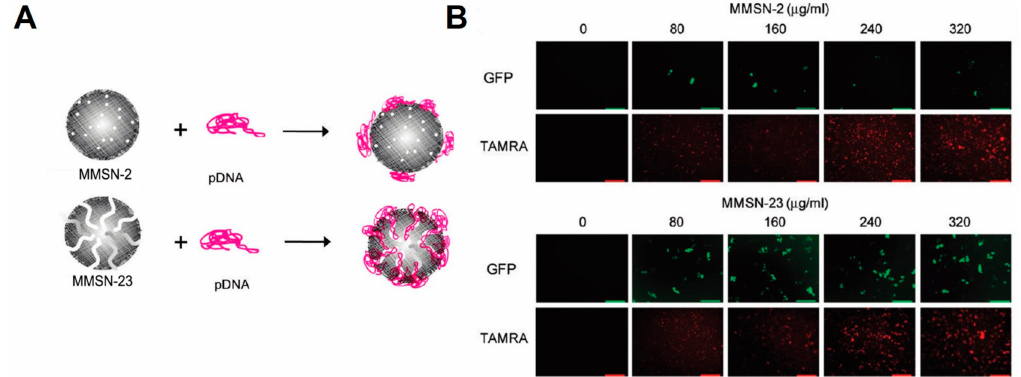
Figure 2. ( A ) Schematic illustration on preparation of DNA-MSN complexes with MMSN-2 or MMSN-23 as carriers; ( B ) Confocal fluorescent images of HeLa cells treated with pDNA(GFP)-MMSN-2 or pDNA(GFP)-MMSN-23. MMSNs were labeled with TAMRA. pDNA, 0.5 µ g. Adapted from reference [55] with